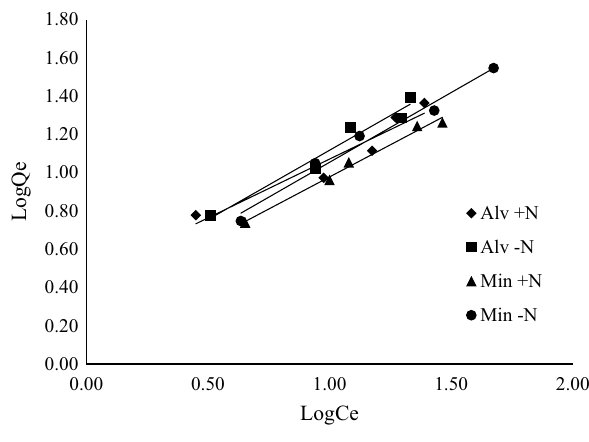
Fig. 14 Freundlich isotherm for copper ions onto N. alveolaris + N, N. alveolaris –N, N. minuta + N, and N/ minuta –N algae